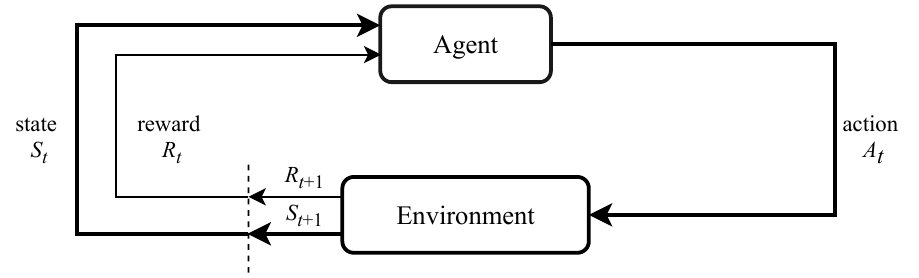
Figure 2. A standard reinforcement learning framework (reproduced from [14] (p.